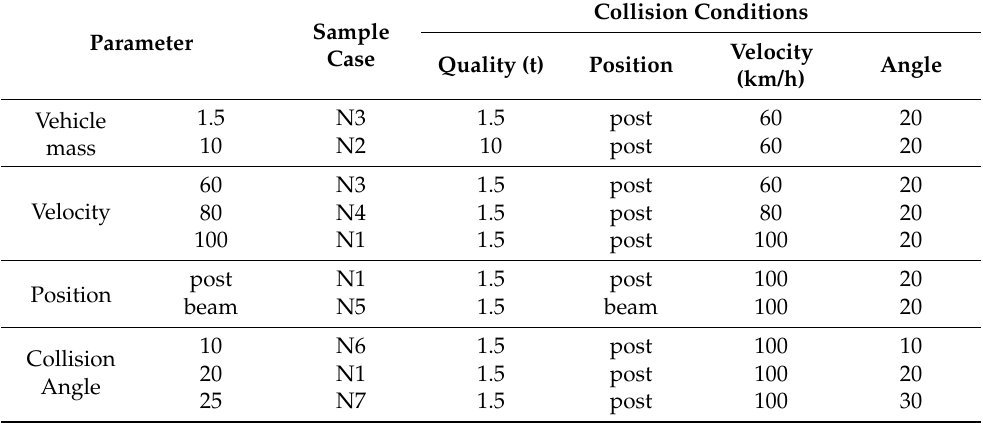
Table A7. Working conditions